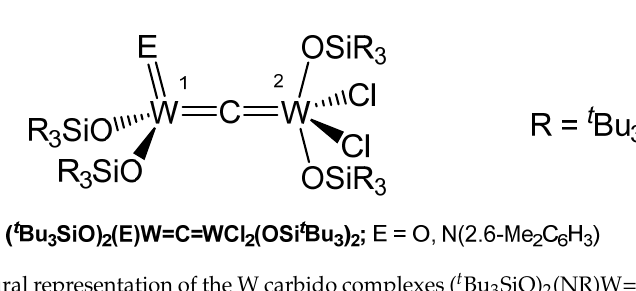
Figure 41. Structural representation of the Fe=C=Cr carbido complexes (TPP)Fe=C=Cr(CO) 5 and (TAP)Fe=C=Cr(CO) 5 . 4. Conclusions The experimental and theoretical research with regard transition metal complexes with carbone ligands [M]-CL 2 and carbido complexes [M]-C has blossomed in the recent past and it can be foreseen that it will remain a very active area of organometallic chemistry in the future. The well-known family of transition metal complexes with C1-bonded carbon ligands that comprise alkyl (CR 3 ), carbene (CR 2 ), and carbyne (CR) groups has been extended by carbones (CL 2 ) and carbido (C) ligands. The summary of recent work, which is described in this review, indicates that carbone and carbido complexes are still largely terra incognita and that many new discoveries can be expected. Author Contributions: Conceptualization and writing of the first draft, W.P. and G.F. Checking and partial visualization L.Z. and C.C. All authors have read and agreed to the published version of the manuscript. Funding: The work at Marburg was financially supported by the Deutsche Forschungsgemeinschaft. L.Z. and G.F acknowledge the financial support from Nanjing Tech University (grant number 39837132 and 39837123), National Natural Science Foundation of China (Grant No. 21703099 and 21993044), Natural